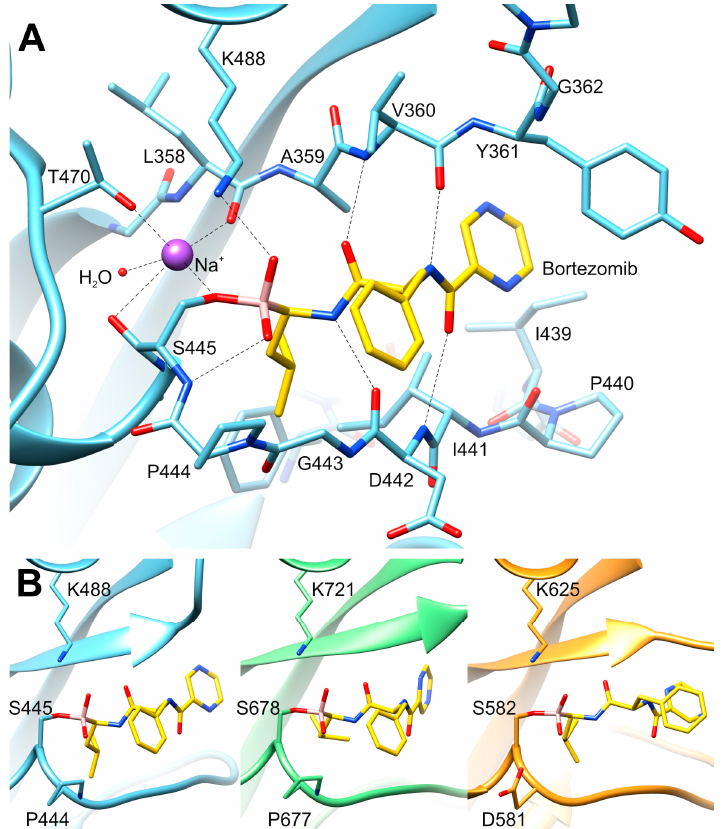
Figure 6. Proteolytic active site of Lon proteases inhibited by bortezomib. ( A ) Structural details and major interactions of bortezomib and sodium ion bound to the active site of Bs LonBA; ( B ) Side-by- side comparison of bortezomib inhibiting the active sites of various Lon proteases: the structures of Bs LonBA, Mta LonA (4ypm), and h MtLonA (6x27) are shown from left to right. High-resolution crystal structures that include bortezomib-inhibited protease do- mains are available for h MtLonA (PDB ID 6x27), LonA from M. taiwanensis ( Mta LonA) (4ypm), and Mta LonC (4fwd) [33]. There are currently no published data available for any